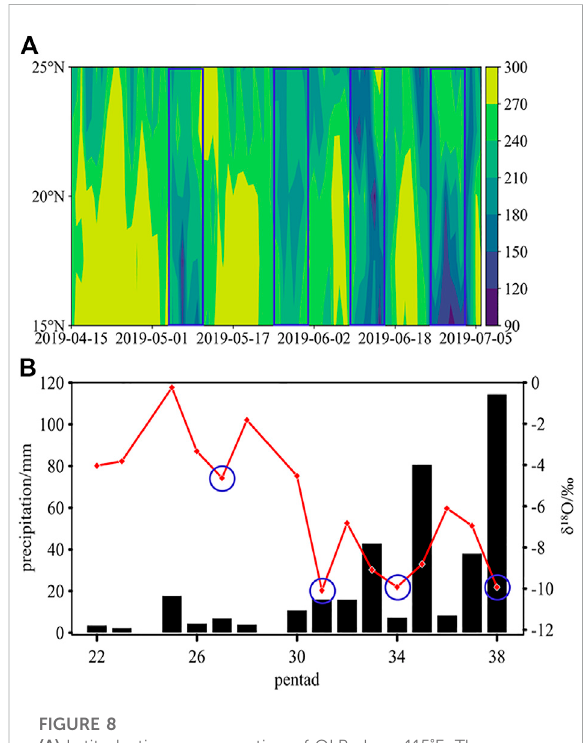
FIGURE 8 (A) Latitude-time cross-section of OLR along 115 ° E. The vertically blue rectangles indicate the relatively low OLR value. (B) Time series of pentad averaged δ 18 O p of precipitation events. The blue circles represent the relative negative δ 18 O p value.